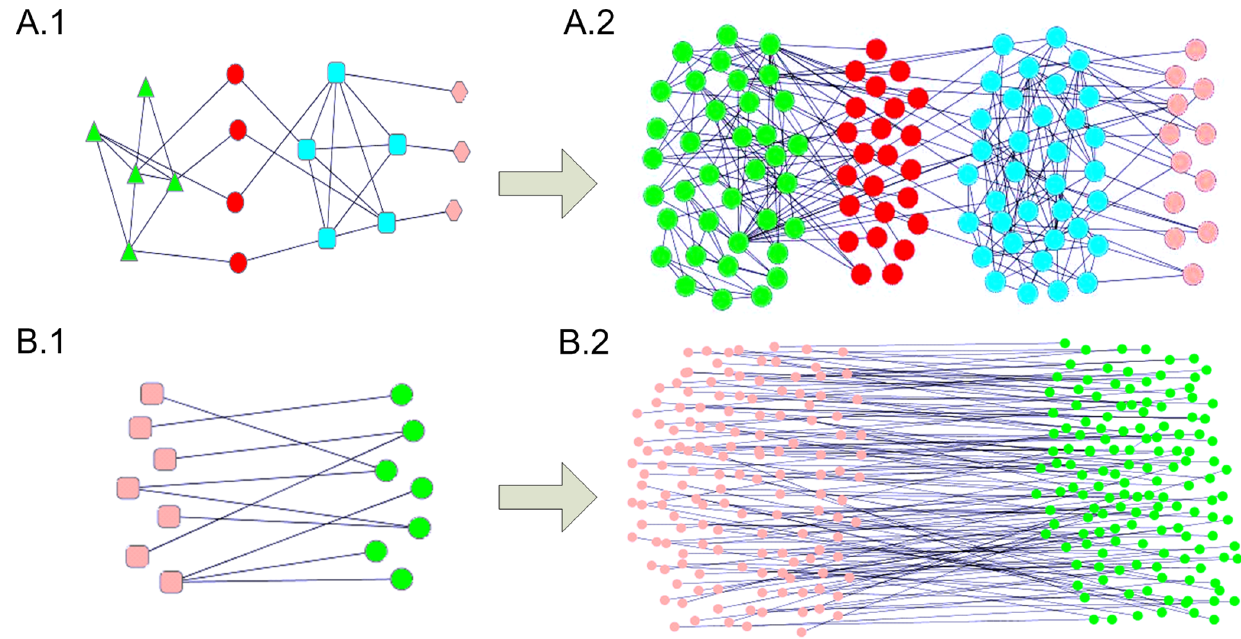
Figure 5. Two possible organizations of sparse modules in the network.